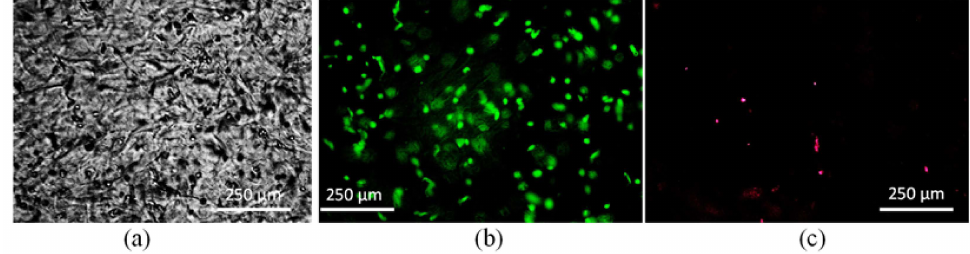
Figure 17. ( a ) Cell encapsulation with A 2 C 2 T 1 . Determining cell viability of bioink before printing